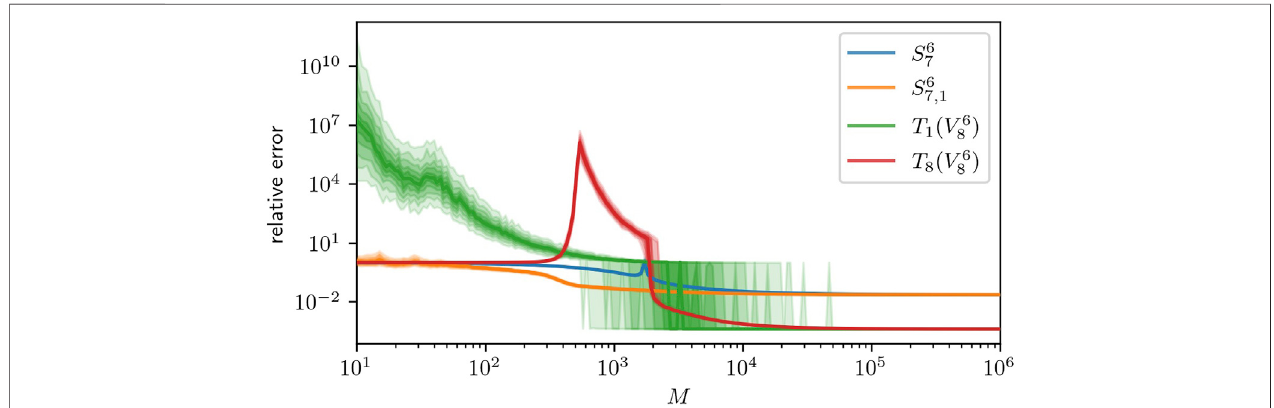
FIGURE 2 | 0.15 – 0.85 quantiles for the recovery error in S 6 7 (blue), S 6 7 , 1 (orange), T 1 ( V 6 8 ) (green), and T 8 ( V 6 8 ) (red). The relative error is computed with respect to the L 2 -norm using a Monte Carlo estimation with 10 6 samples.